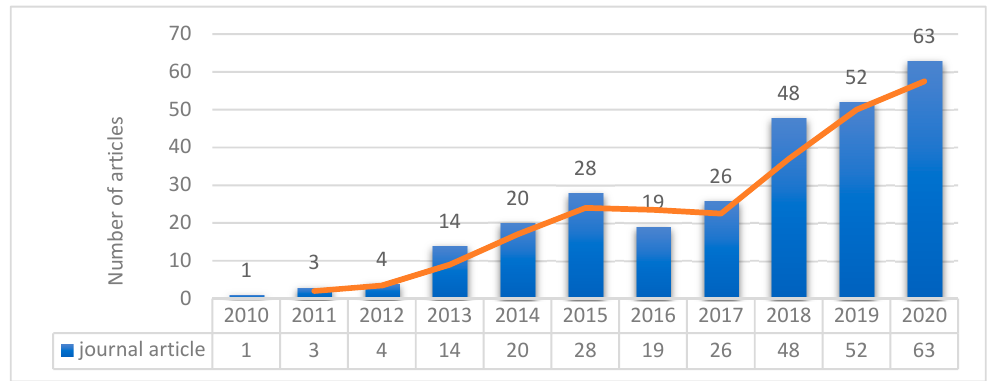
Figure 2. Published articles over the last decades related to BIM in monitoring and maintenance. Table 1. Journals with the most relevant